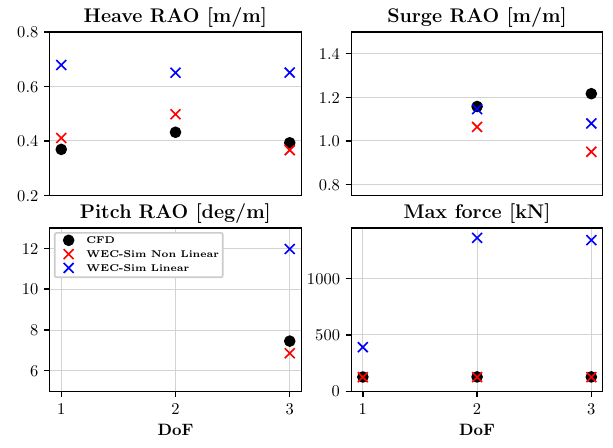
Fig. 6. The RAOs for heave, surge, and pitch motion for cases with 1, 2, and 3 DoF, as calculated by mid and high-fidelity solvers. The maximum force in the connection line is also depicted in the lower- right plot. In terms of the midfidelity model, the linear and weakly nonlinear approaches are also